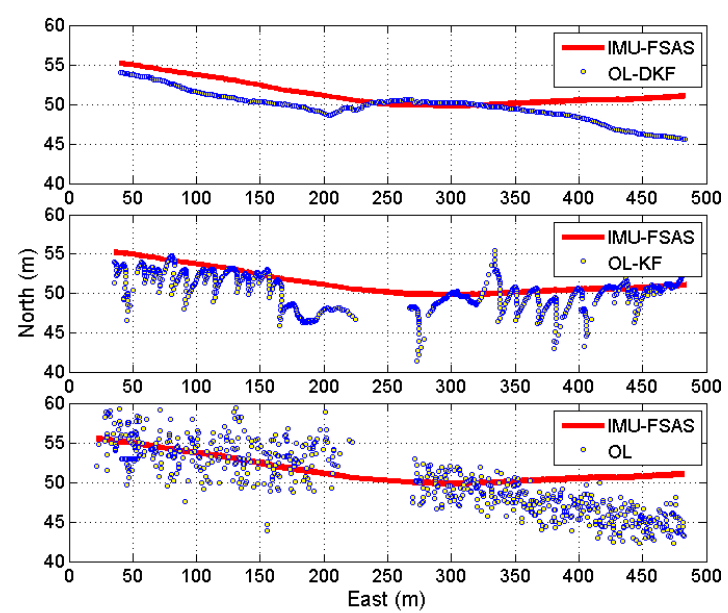
Figure 23. Position plot of OL-DKF, OL-KF and OL against IMU-FSAS of roads blocked by a light railway test.